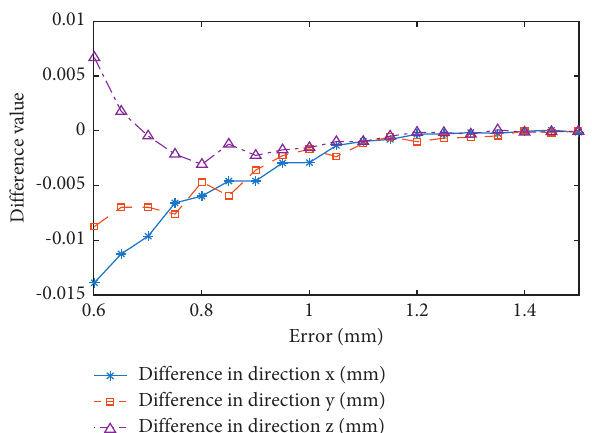
Figure 9: Differences between the envelope method and MCS method in directions.